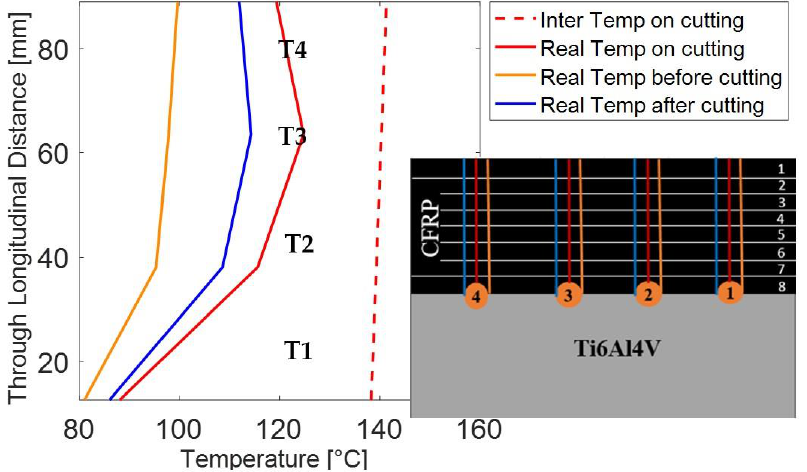
Figure 9. The temperature through the longitudinal distance for the titanium plaque using tool3, v of 175m/min, ft of 0.05 mm/tooth, and ae of 1mm.